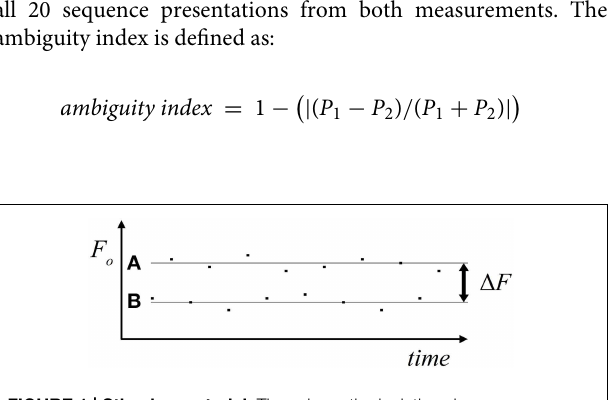
FIGURE 1 | Stimulus material. The schematic depiction shows, as an example, part of a sequence of the 1 F condition of 10 semitones. Squares represent the A and B tone complexes. The geometric means of their F 0 (gray lines) differ by 10 semitones (logarithmic scale). The F 0 of the individual exemplars of A and B tone complexes differ from their geometric means by 0, ± 1, or ± 2